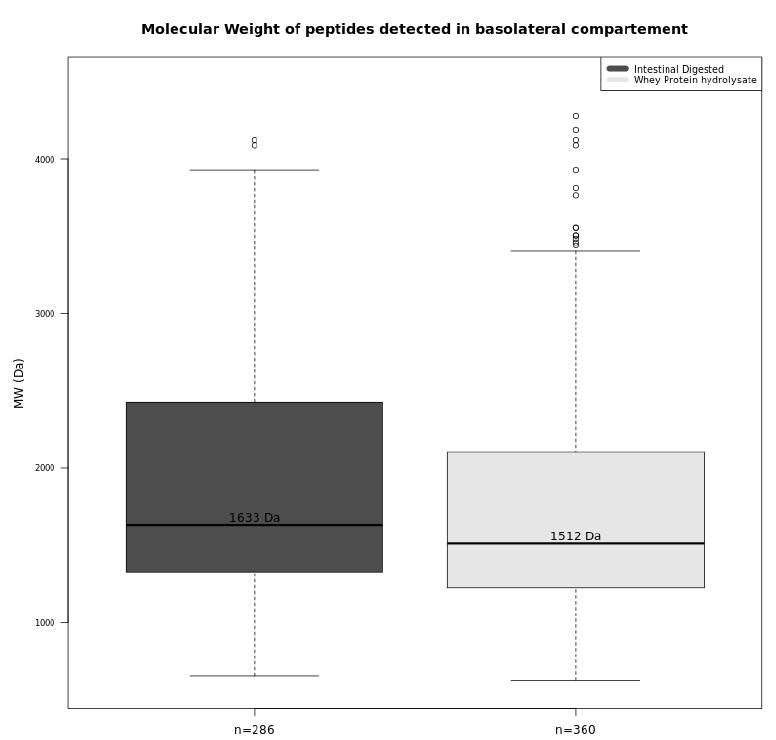
Figure 3. Median molecular weight and total number of peptides identified for undigested (WPH) and intestinal digested (ID) whey hydrolysate during the UC absorption study on basolateral compartments.